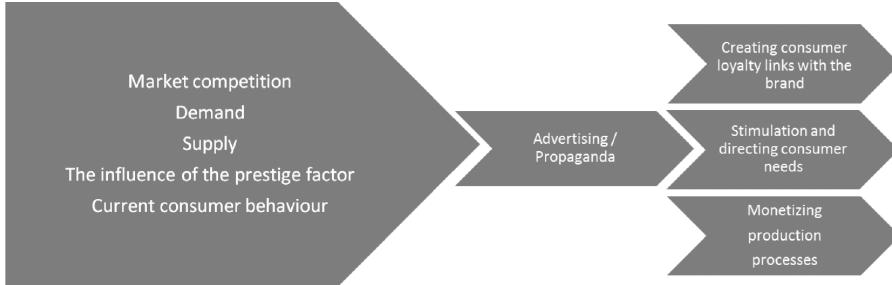
Figure 10. Model of the functioning of economic propaganda in the capitalist